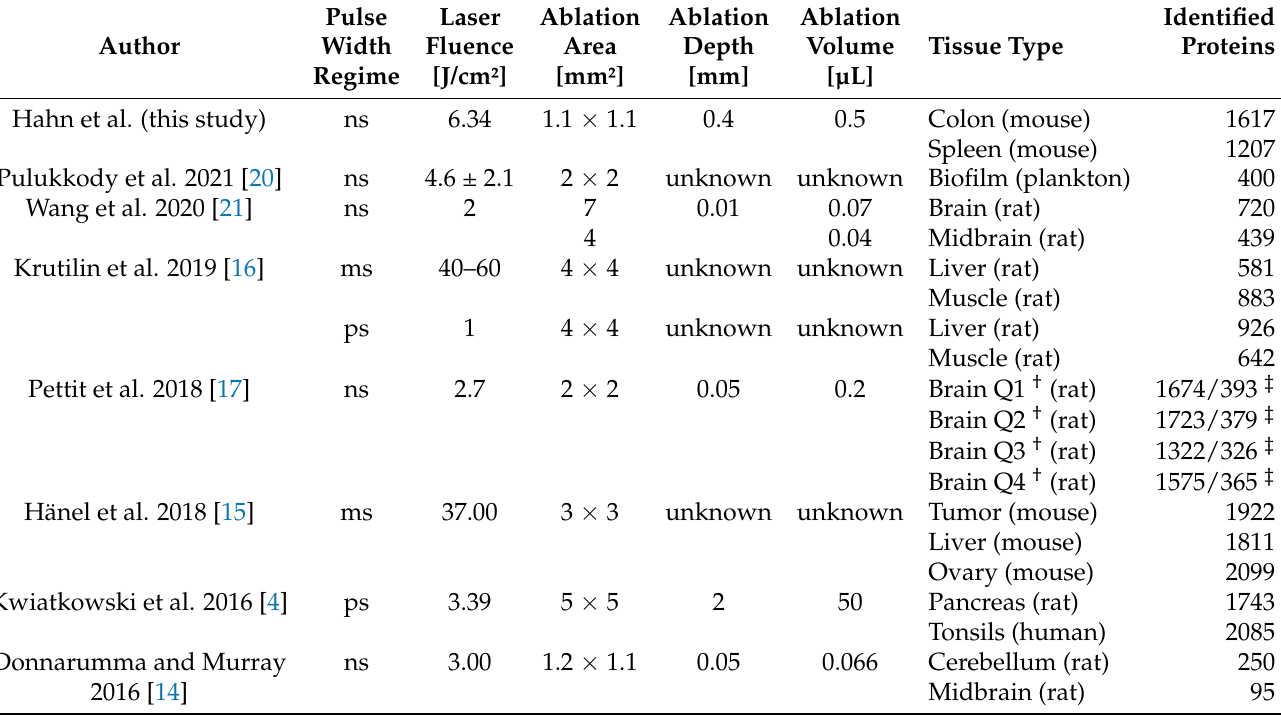
Table 2. Parameters and identified proteins of different studies sampling different tissues with an IR-laser with 2.94 µm wavelength and analyzing the samples with mass spectrometric bottom-up